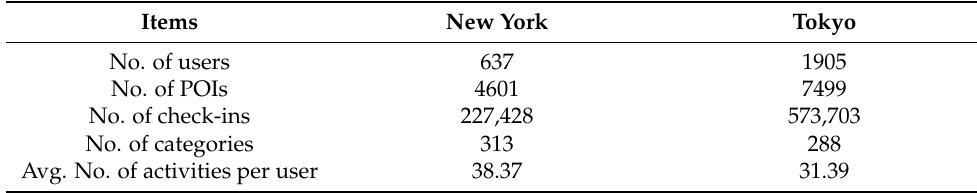
Table 2. Measurements of